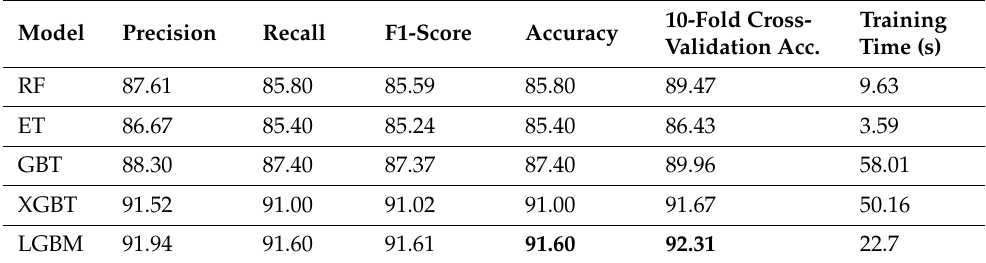
Table 3. Results on the test set with 15 packets as input.